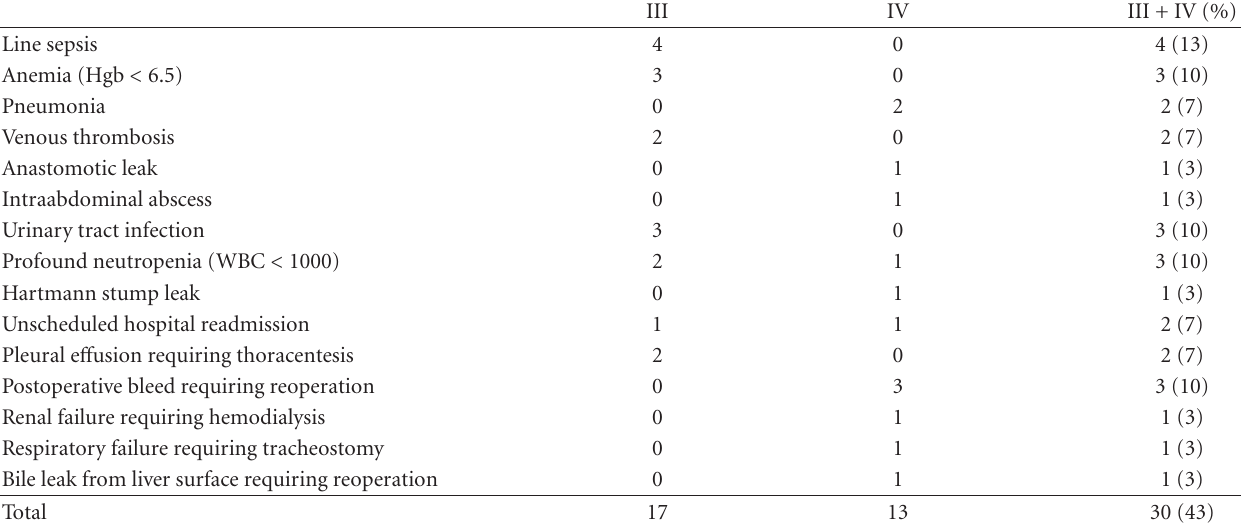
Table 2: Causes of grade III or IV adverse events. There were 30 adverse events in 13 patients